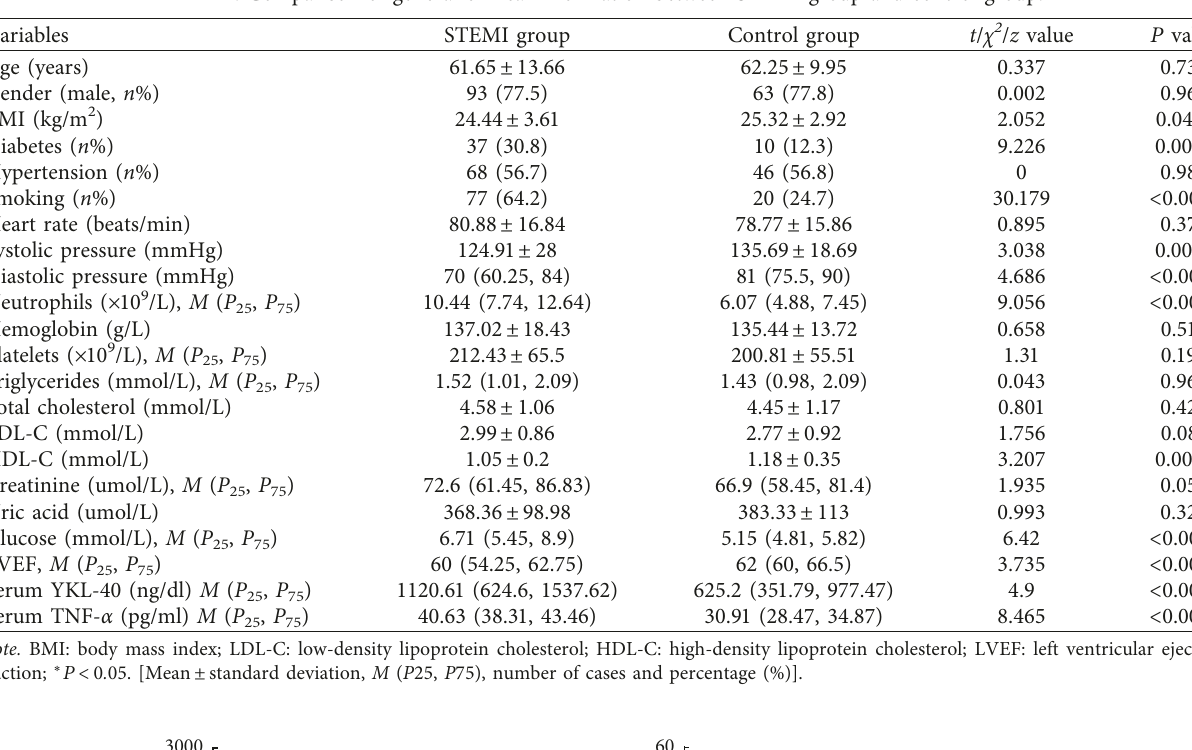
Table 1: Comparison of general clinical information between STEMI group and control group.